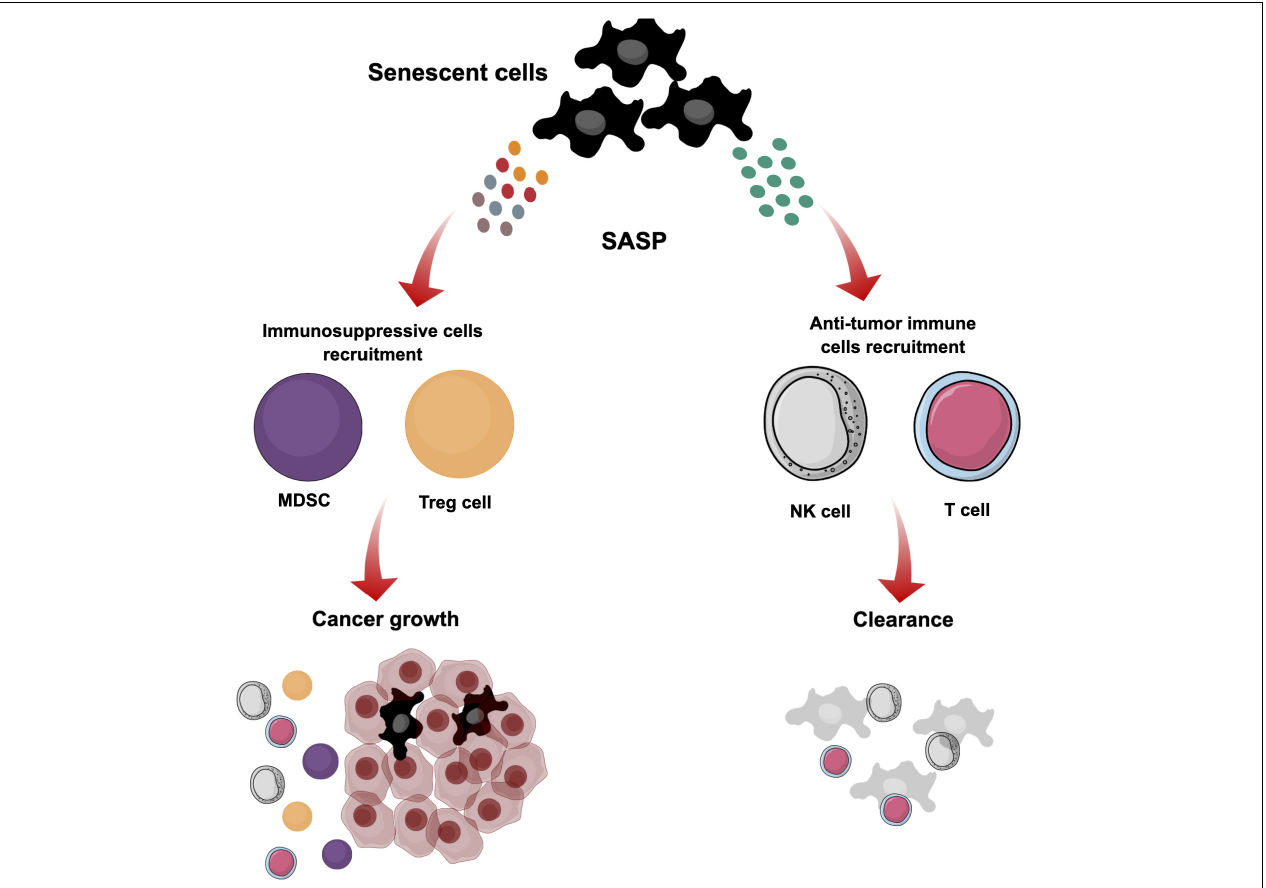
FIGURE 4 | The dual role of cellular senescence. Senescent cells are induced in the TME by different stimuli. These cells stop proliferating but maintain active metabolism and transcription. They produce different SASP secretions that reflect the dual role of senescence. They can produce particular SASP secretions to recruit immune cells such as NK and T cells for clearance and suppression of tumorigenesis. However, modification of SASP secretions blocks the elimination of senescent cells by immune cells, and subsequently they can have a negative influence in the tissue microenvironment by supporting cancer growth and recruiting immunosuppressive cells such as MDSCs and Treg